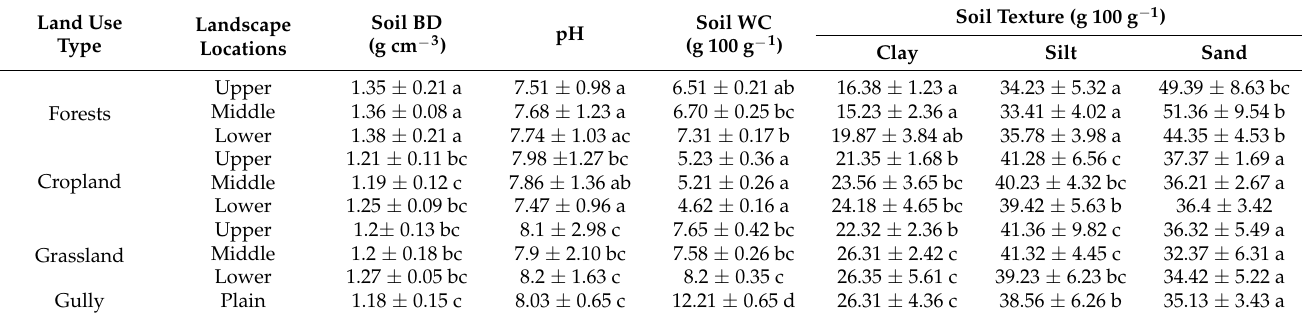
Table 1. Selected soil physiochemical properties at various land uses and landscape locations.